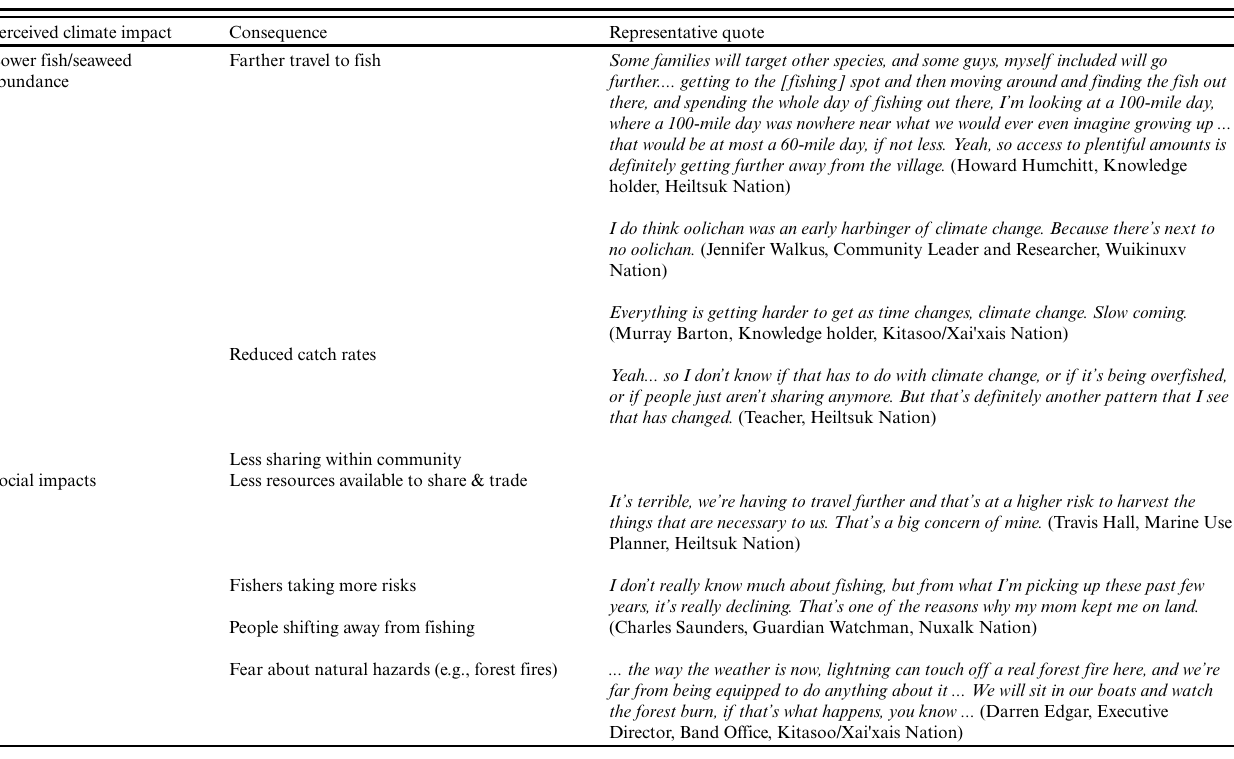
Table 3 . Perceived consequences on participants’ way of life from climate change impacts on the marine and coastal ecosystem. Quotes without direct attributions are anonymous.